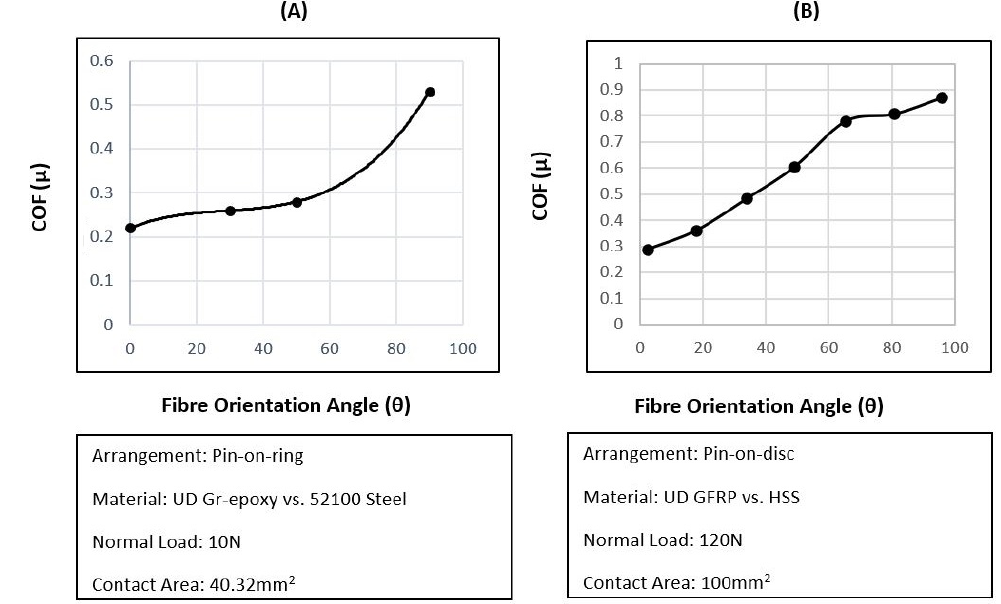
Figure 2. ACOF as a function of fibre angle